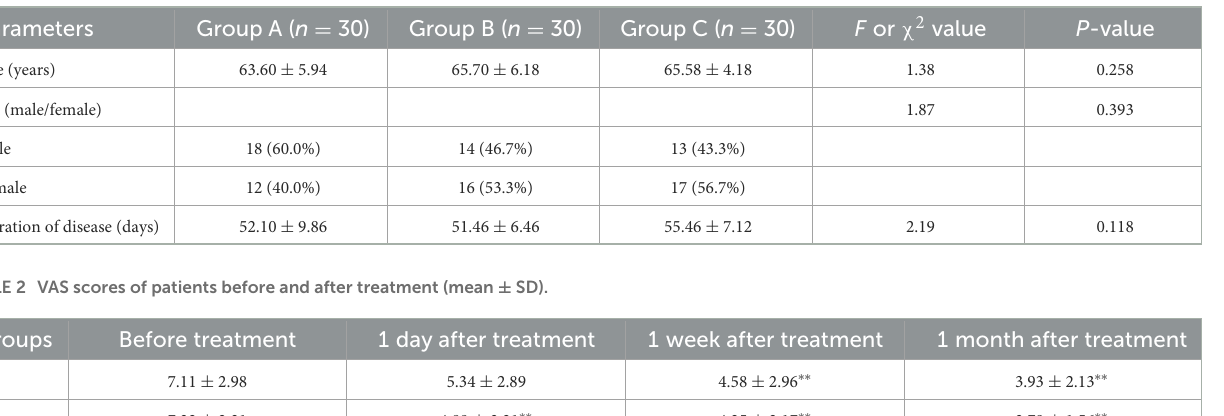
TABLE 1 Comparison of general information in three groups of patients.